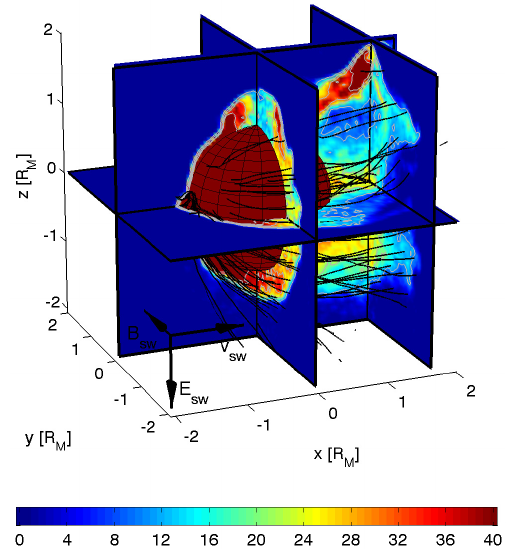
Fig. 5. Simulated ionospheric parameters (adaped from B¨oßwetter et al., 2004). The cutting planes show the heavy ion density (O + ) in cm − 3 . The black solid lines represent the stream lines of the corresponding velocity field. The heavy ions form a complex tail structure behind the